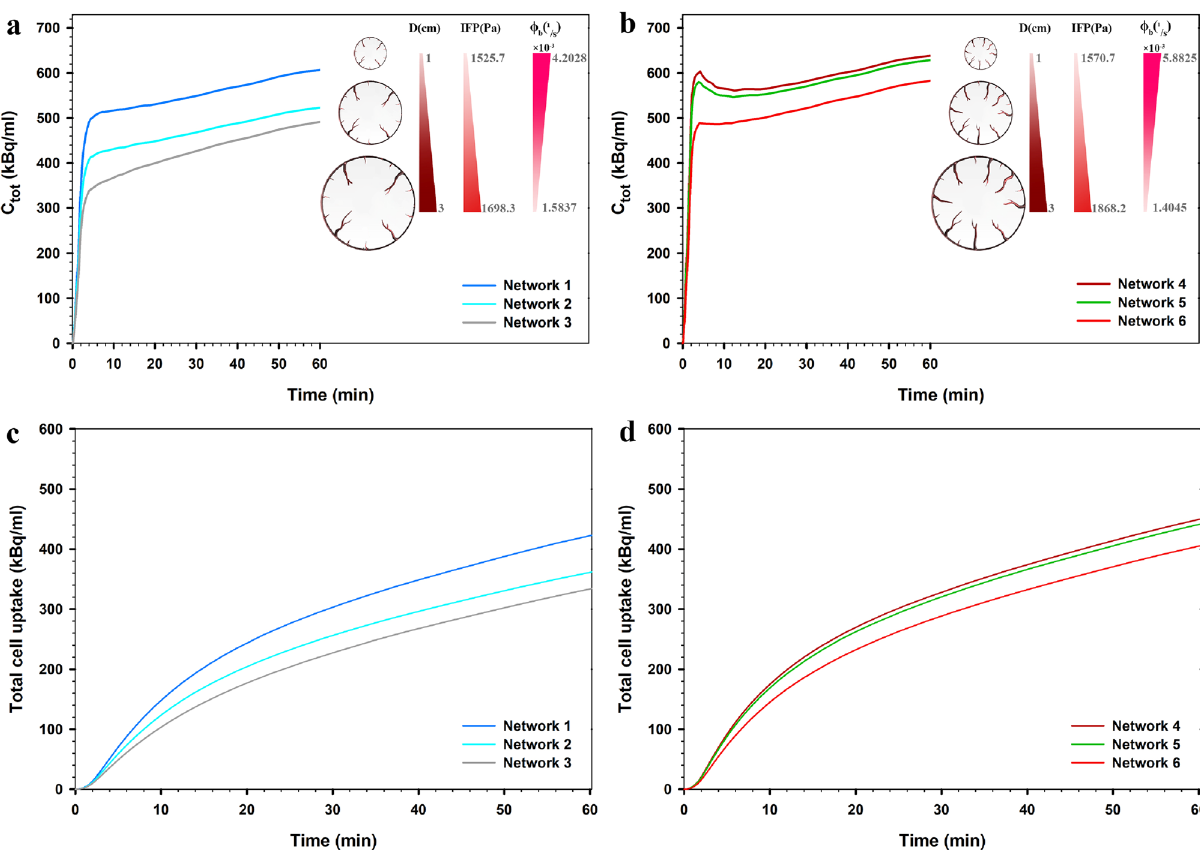
Figure 12. Effect of tumor size on total FDG concentration across the tumor tissue and total cell FDG uptake for the networks of first state considering 3 initial sprouts ( a , c ) and the networks of second state considering 5 initial sprouts ( b , d ).